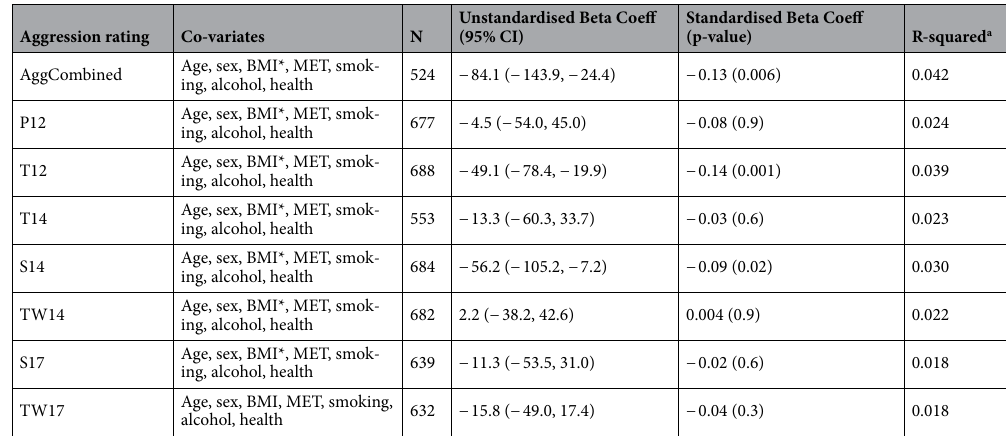
Table 2. FinnTwin12 multivariable linear regression models with 3-hydroxybutyrate as the response variable, regression coefficients of aggression ratings from different raters as predictor variables in separate models, adjusted for age, sex, BMI, MET, smoking status, alcohol consumption frequency, self-rated general health, and familial relatedness. AggCombined aggression combined, BMI body mass index, CI confidence interval, MET metabolic equivalent of task, P12 parent rating age 12, S14 self rating at age 14, S17 self rating at age 17, T12 teacher rating age 12, T14 teacher rating age 14, TW14 co-twin rating at age 14, TW17 co-twin rating at age 17. *This co-variate also significant (p < 0.05). a R-squared represents the variation explained from all variables in the model together.